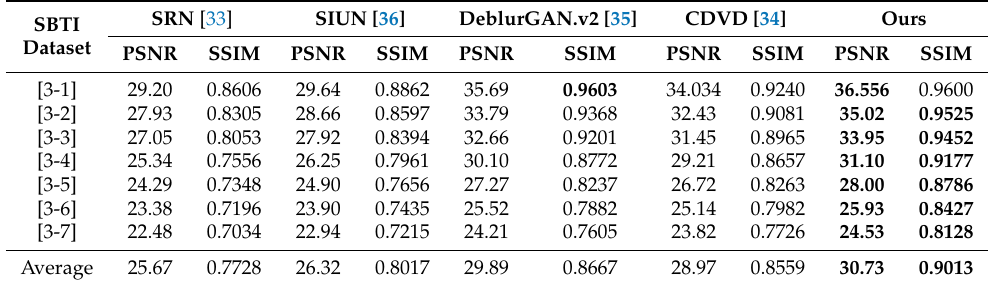
Table 7. Comparison of quantitative deblurring performance on the SBTI dataset [4-1]–[4-7]. SBTI